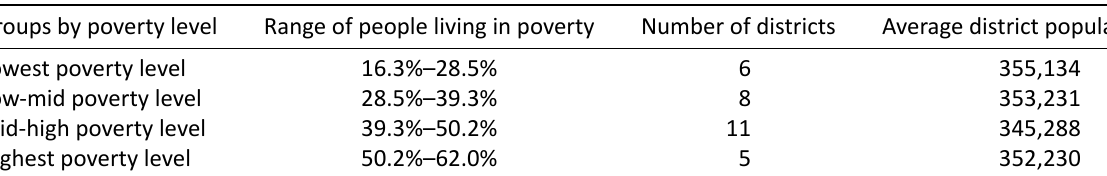
Table 2. District data by poverty category.